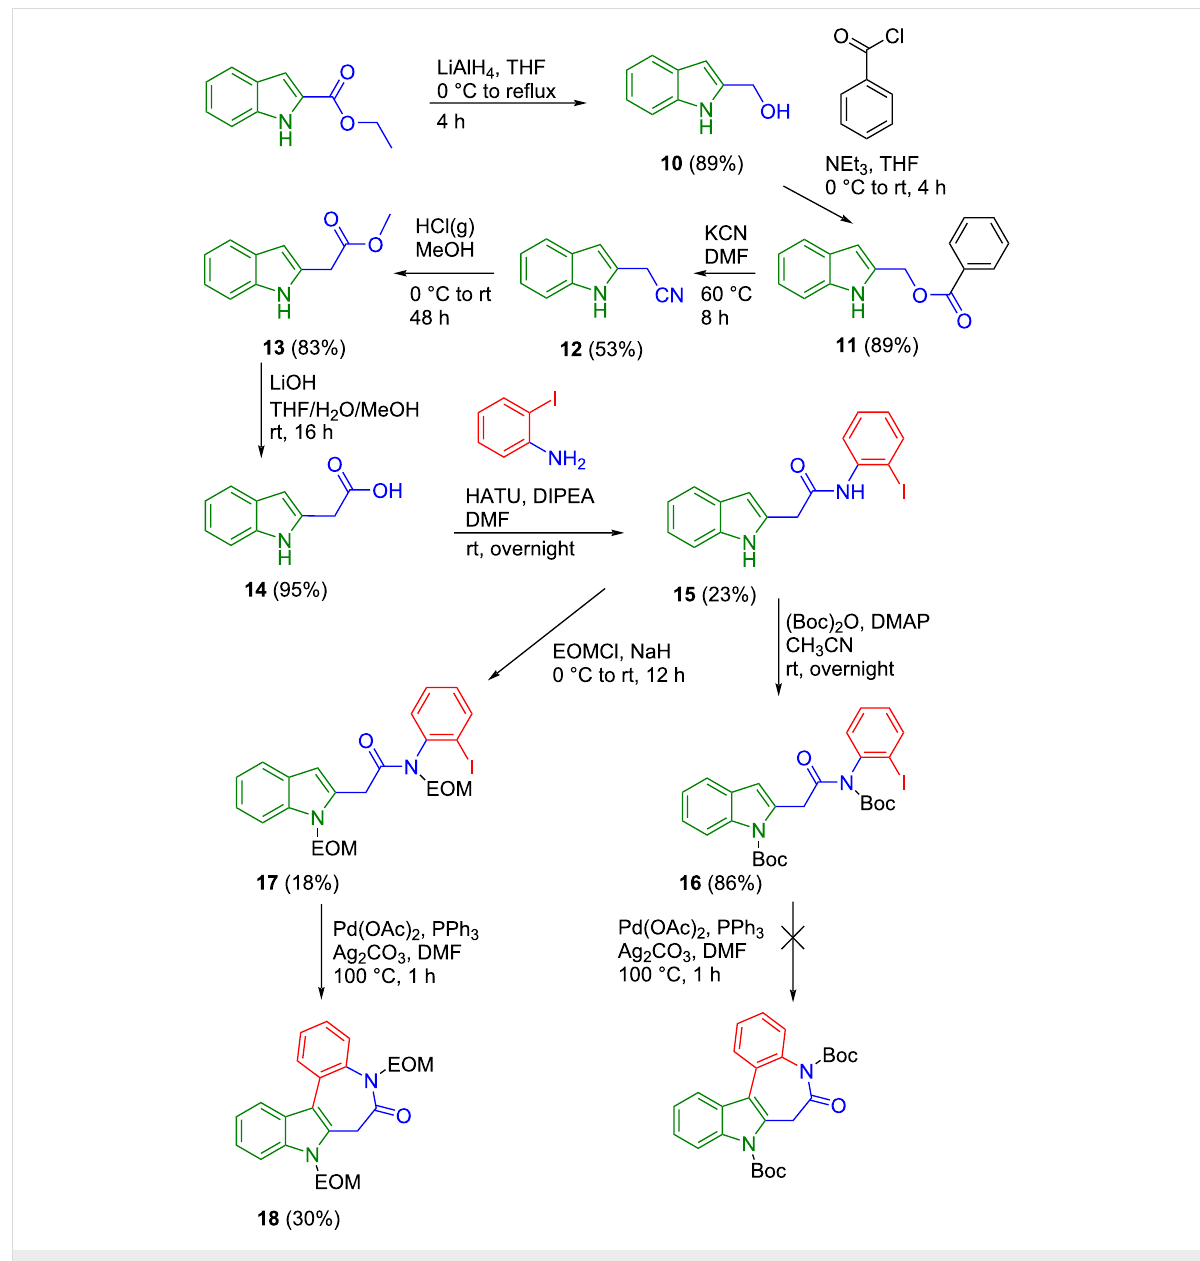
Scheme 3: Attempted synthesis of C by route